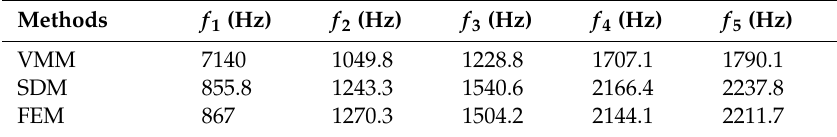
Table 1. The first five natural frequencies of the three equivalent methods of the joint interface.